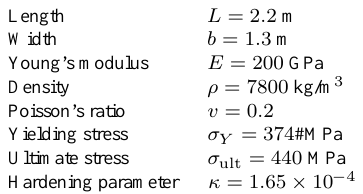
edge. There is an initial gap of 1 mm between door and door frame. There is no initial gap between latch and door frame. Figure 7(b) shows the finite element